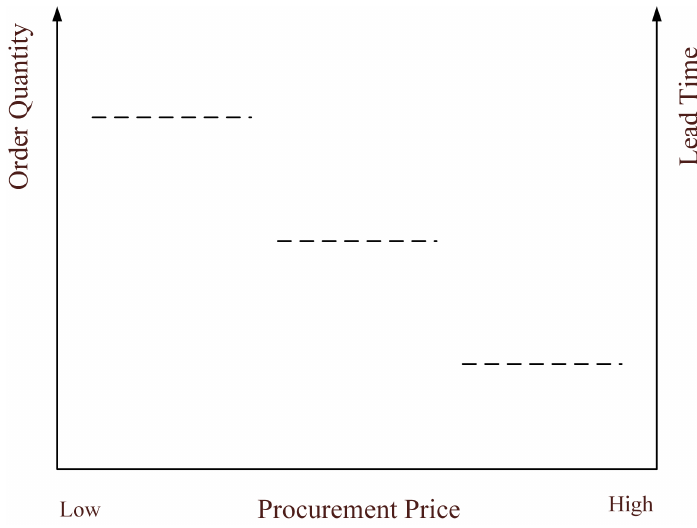
Figure 2. Quantity discount and time discount.